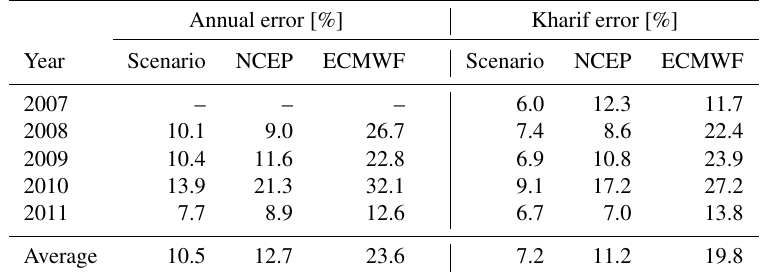
Table 2. Comparison of annual and Kharif (April–September) mean absolute volumetric error [%] of 10-daily flow forecasts using (a)